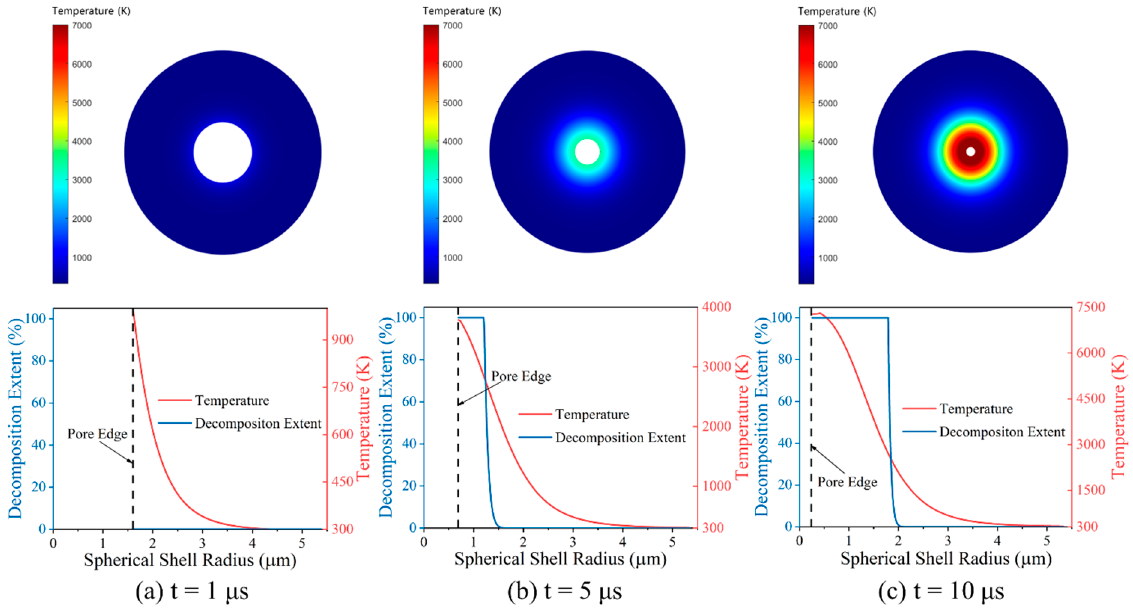
Figure 3. Typical temperature rise of pore collapse and decomposition extent of PTFE at 20 kbar constant pressure loads.